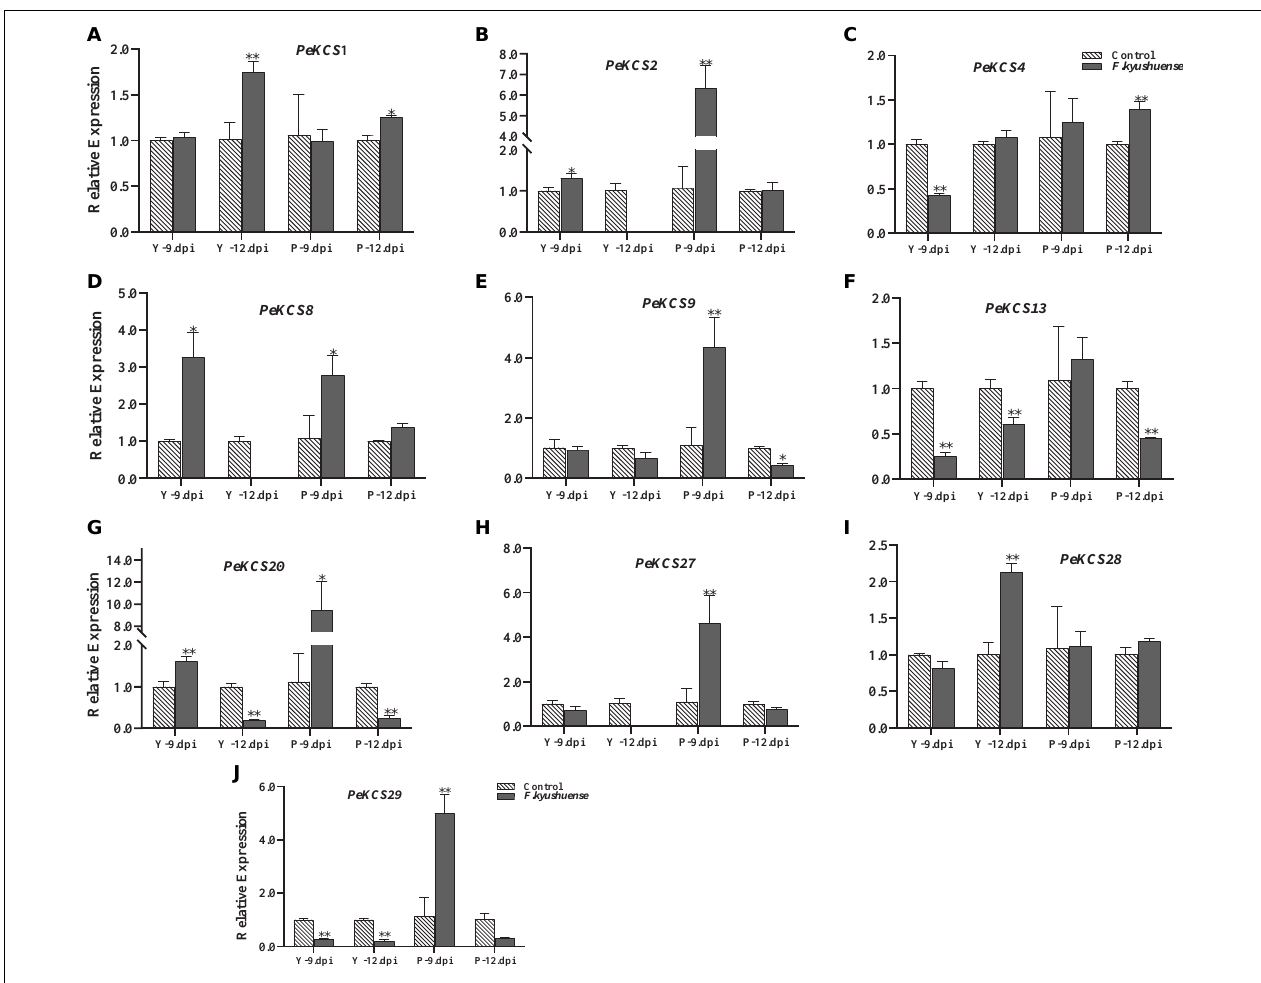
FIGURE 13 | The relative expressions of PeKCS genes in peel tissues of yellow and purple passion fruit plants under F. kyushuense fungal biotic stress and control conditions. The relative gene expression levels were calculated using the 2 - (cid:49) (cid:49) ct . Vertical bars represents means ± SD ( n = 3). The * and ** shows significance at p ≤ 0.05 and p ≤ 0.01, respectively, among control and biotic stress conditions according to Students t -test. Y, yellow passion fruit; P, purple passion fruit; dpi, days post inoculation.